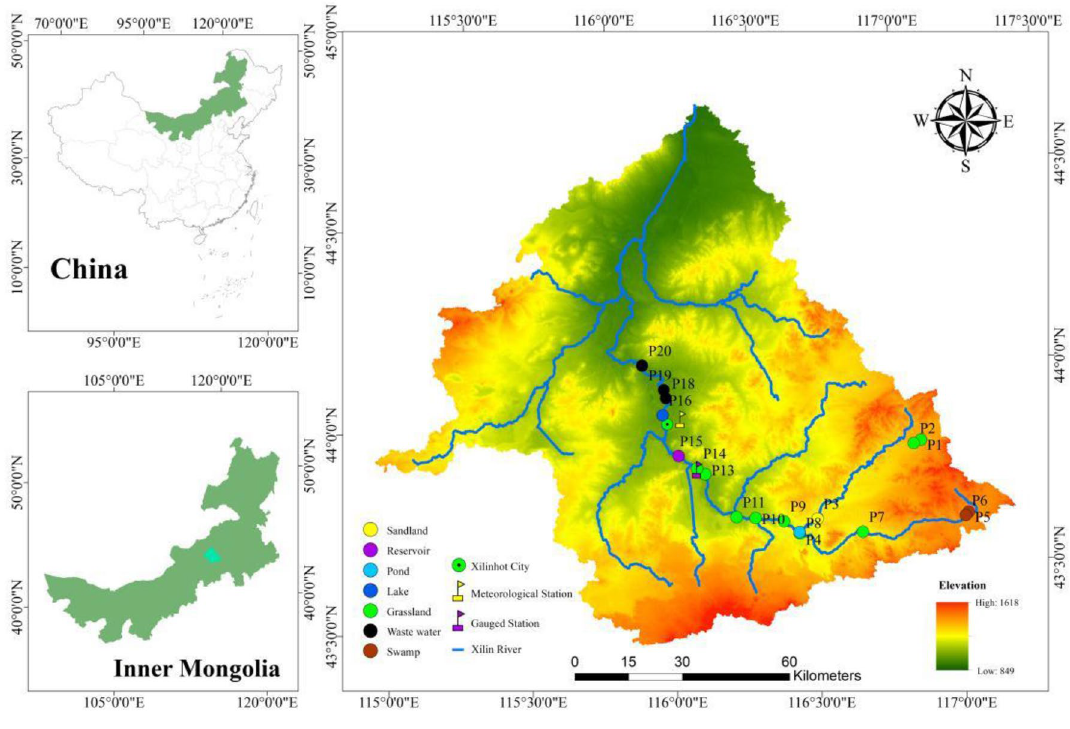
Figure 1. Xilin River Basin and sampling sites (generated by